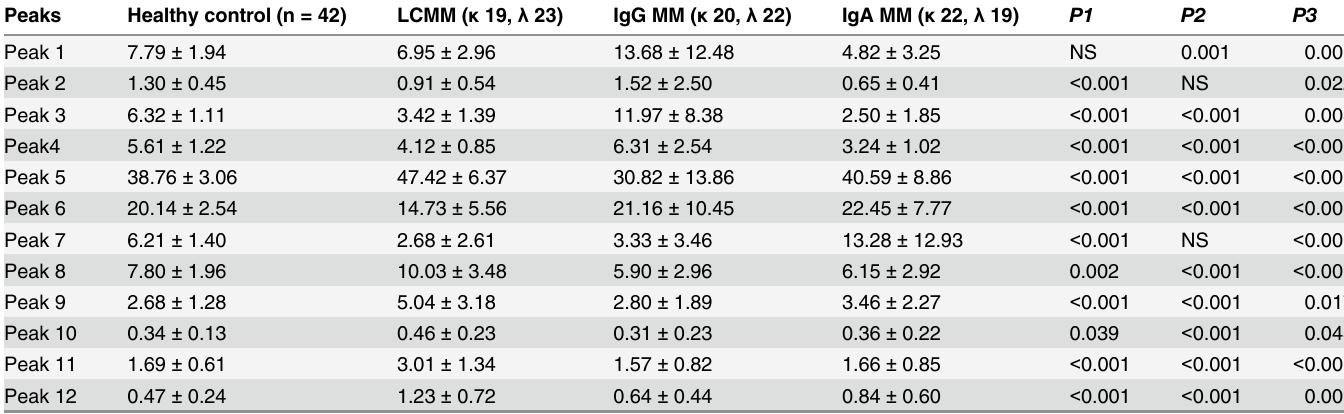
Table 2. Abundance of N-glycan profilings in LCMM, IgG MM, IgA MM patients and healthy